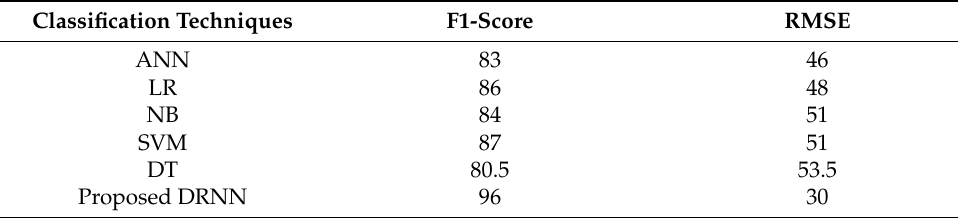
Table 2. F1 ‐ scores and RMSE measures of existing and proposed techniques.